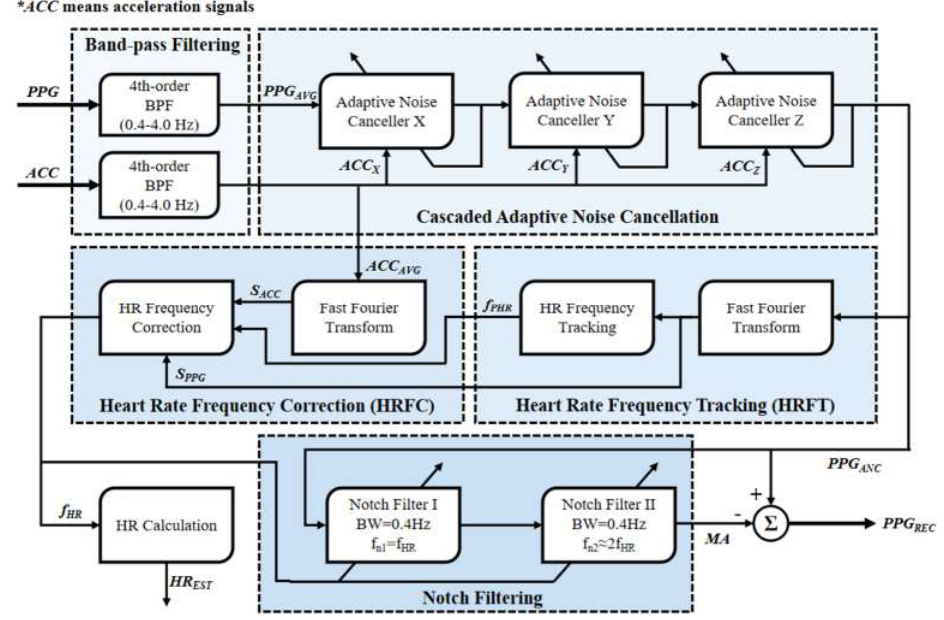
Figure 1. Overall signal flow of the proposed method.